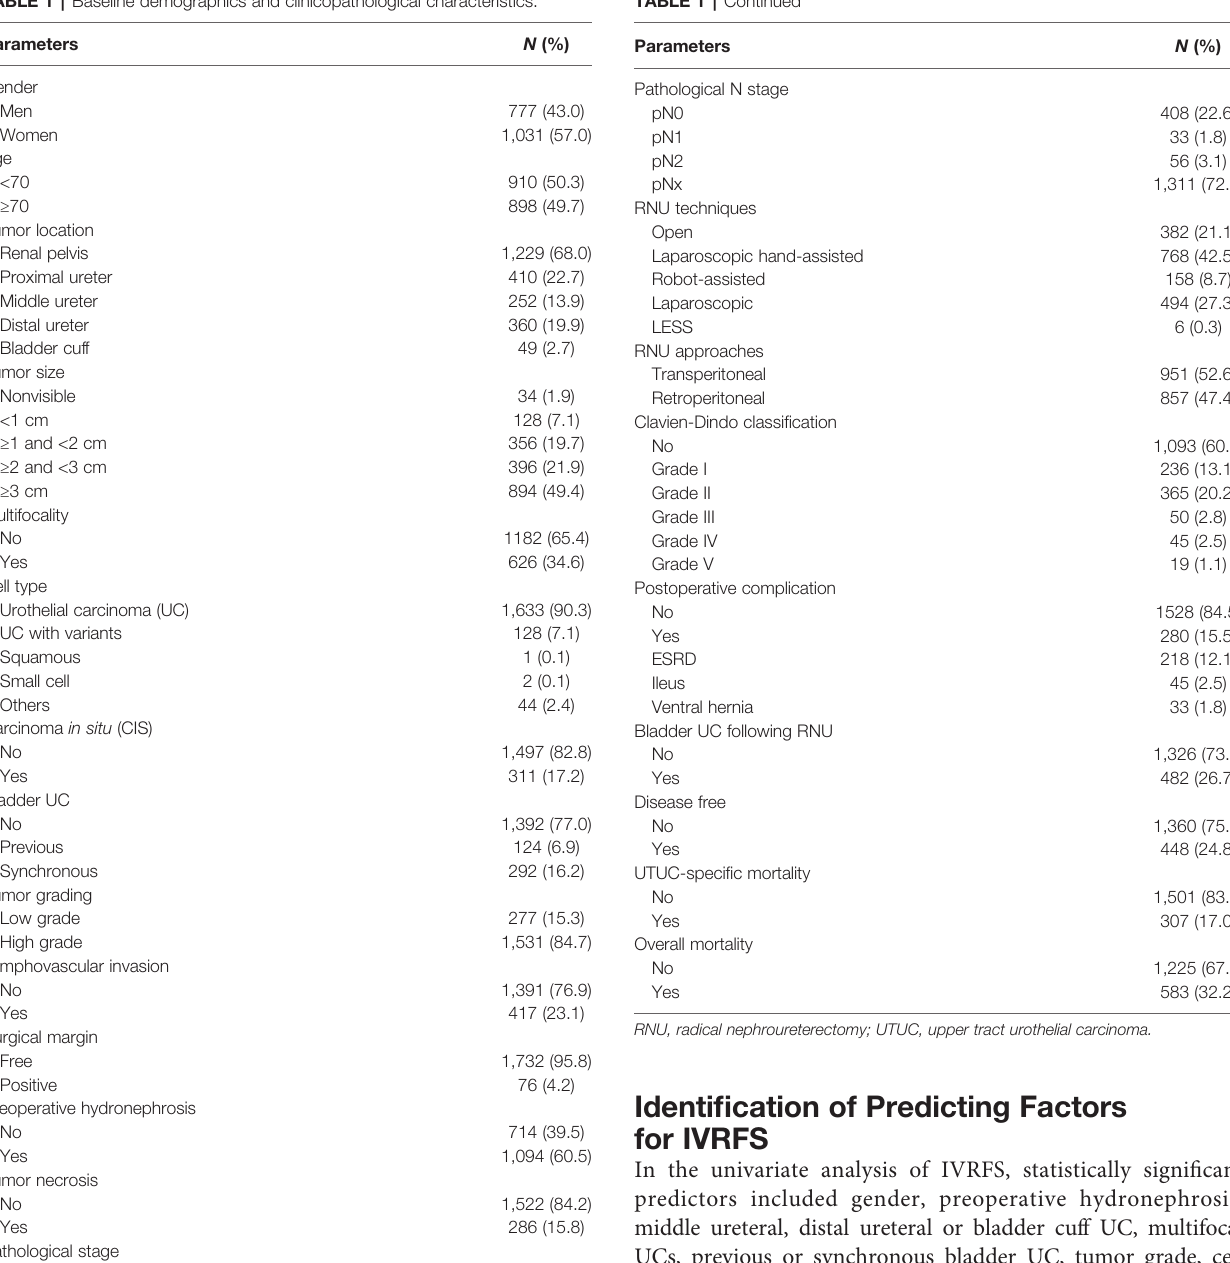
TABLE 1 | Baseline demographics and clinicopathological